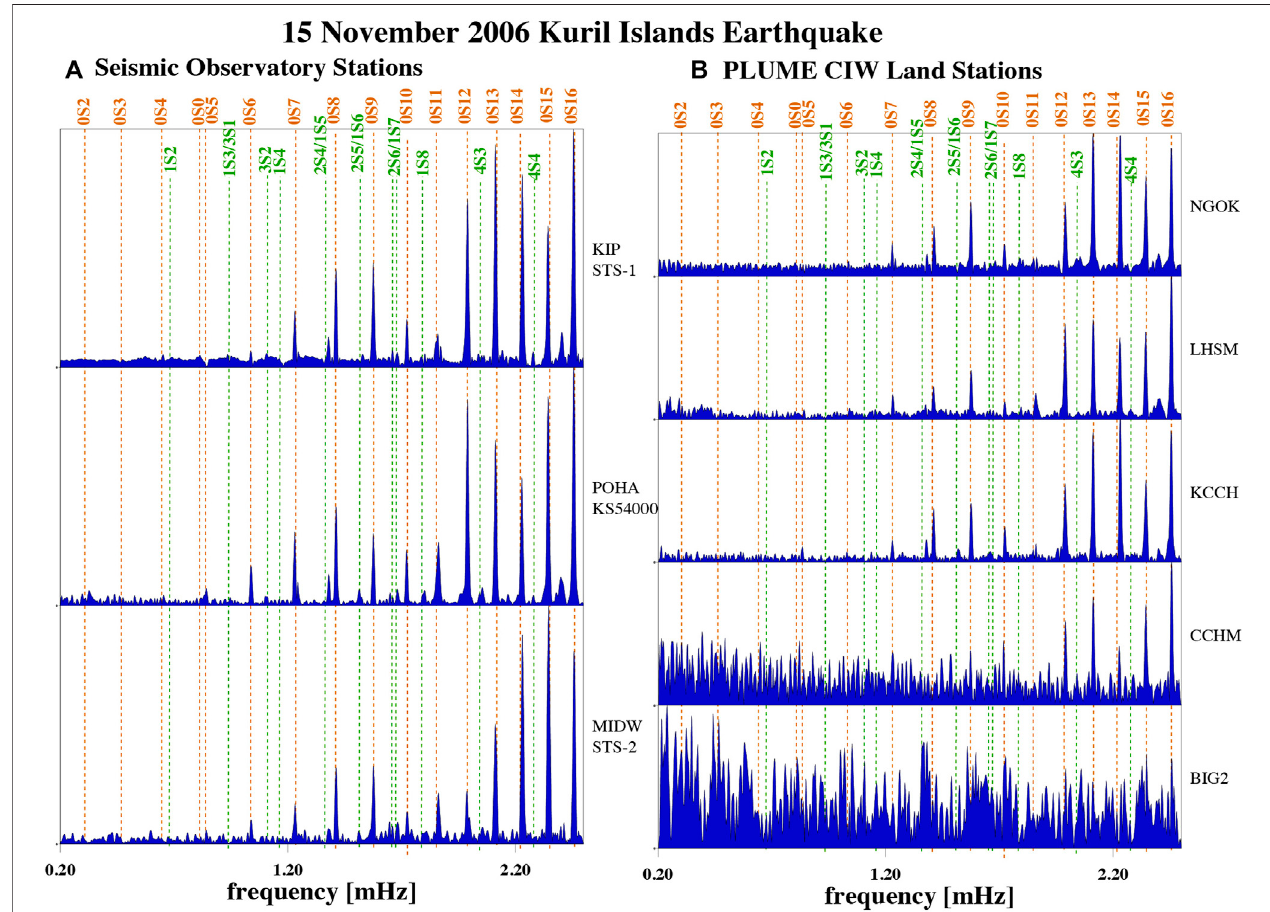
FIGURE 6 | Normalized raw vertical-component spectra for the November 15, 2006 Kuril Islands earthquake of 50-hour long segments, starting 1.5 h after the eventtime. (A) SpectraatstationsoftheGSN.See SupplementaryTableS1 inthesupplementforearthquakeparameters. (B) Spectraatthe fi veCIWlandstationsstill operating at the time. All CIW stations were equipped with a Wielandt-Streckeisen STS-2 seismometer.